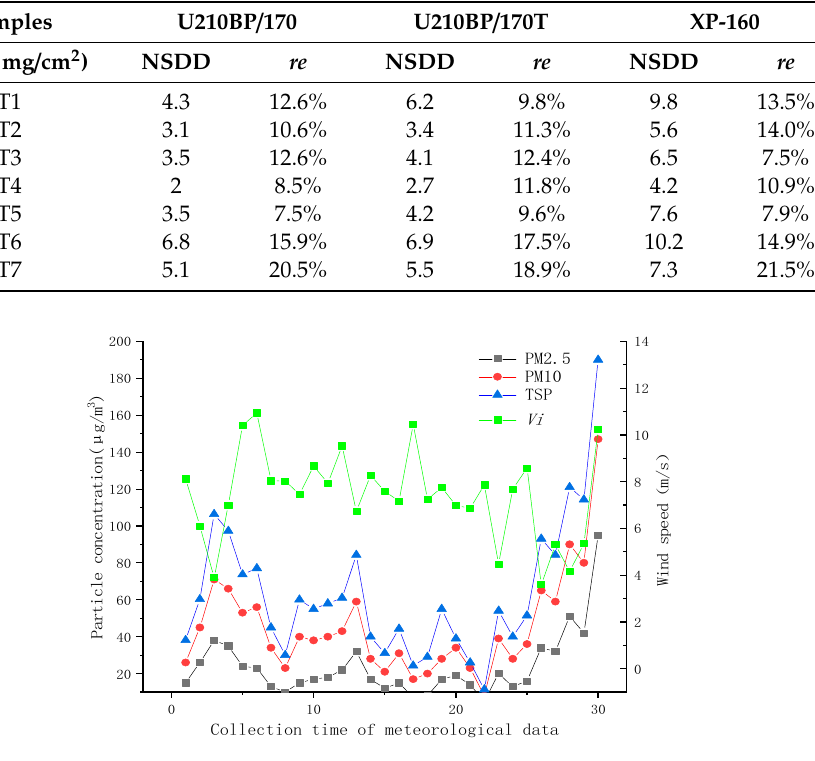
Figure 7. Thirty sets of meteorological data.